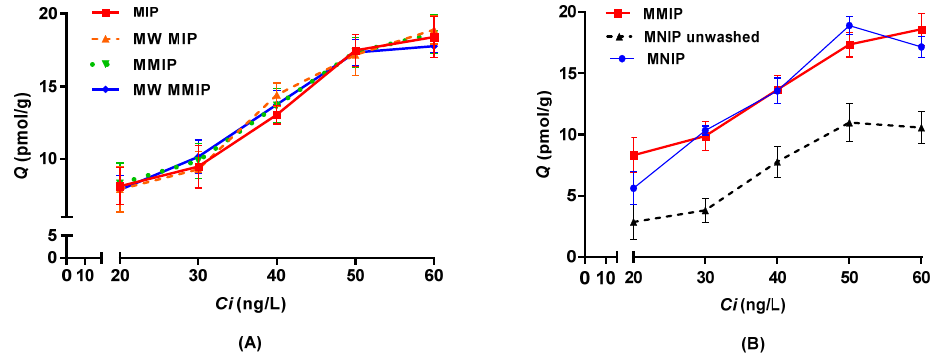
Figure 4. Adsorption isotherms of 3-isobutyl-2-methoxypyrazine (IBMP) (mean ± SD, standard deviation, n = 3) for ( A ) conventional and MW putative imprinted polymers and ( B ) thermally synthesised MMIP, MNIP, and unwashed MNIP. Q : equilibrium adsorption amount; Ci : initial IBMP concentration.